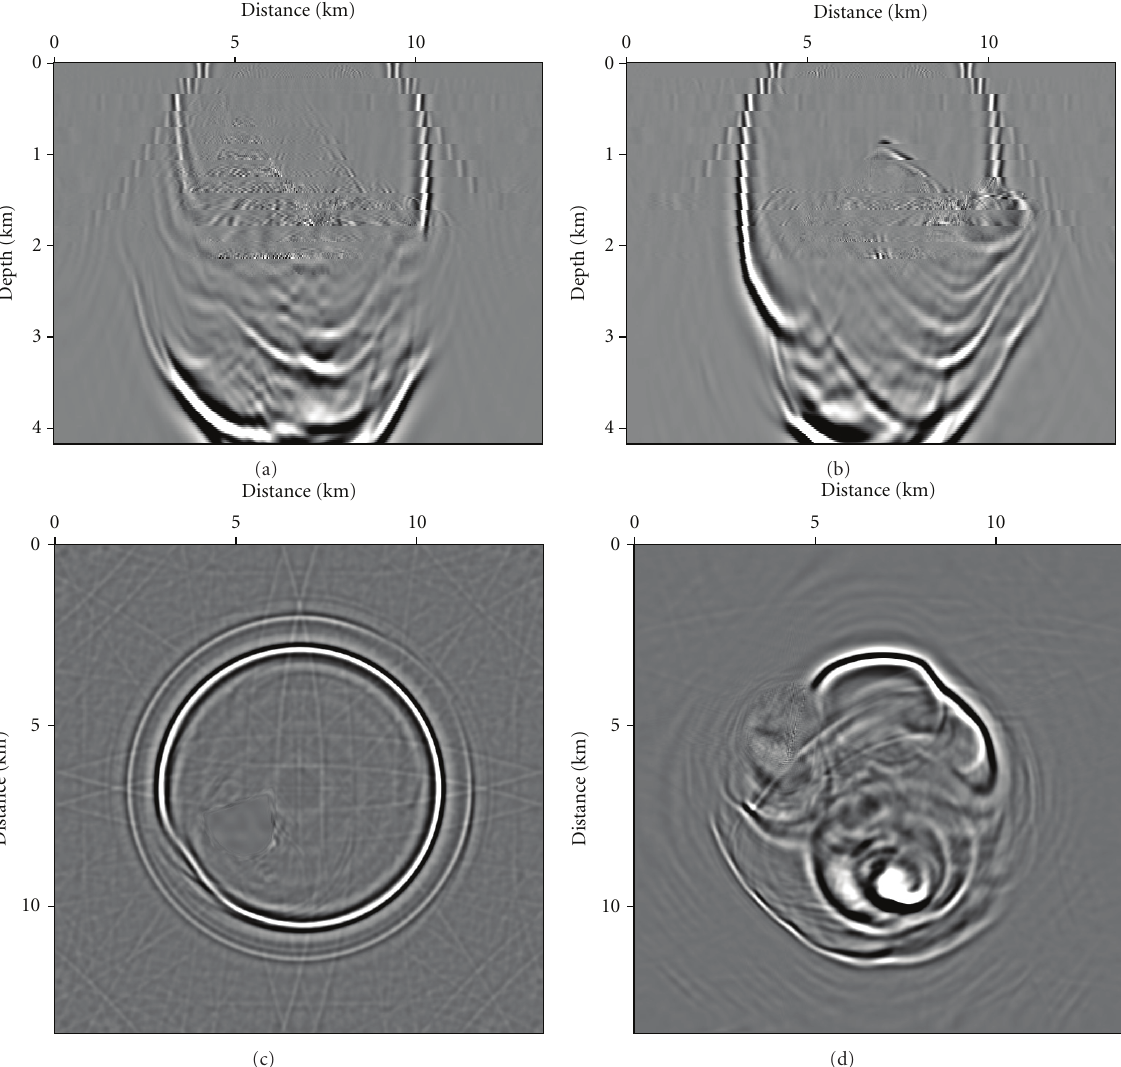
Figure 6: Impulse response obtained by FD migration using the real Pad´e approximation with 2 terms and Li correction (cross-sections as